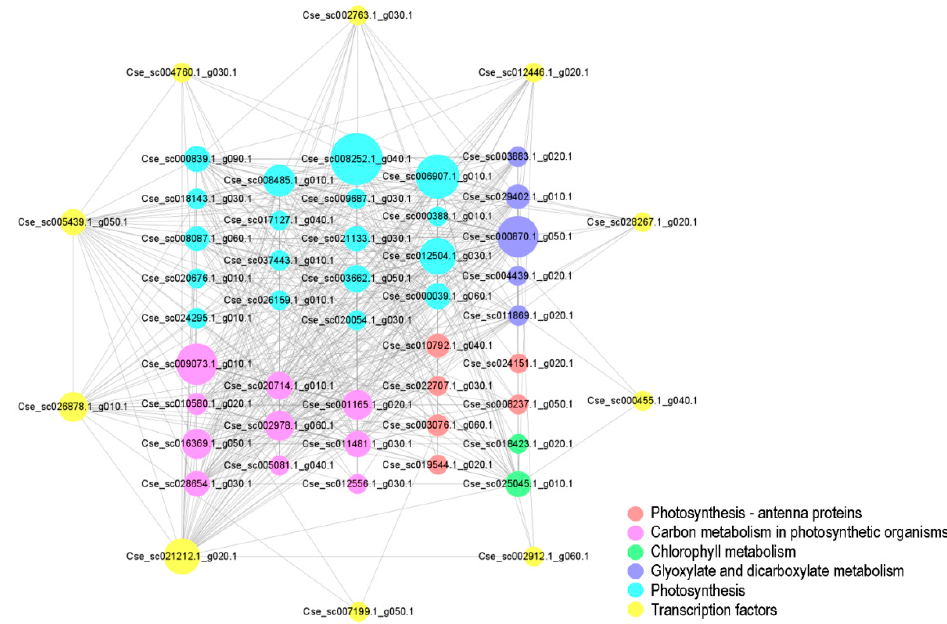
Figure 8. Network of genes in the black module. The network was constructed from 51 genes based on edge weight values. The size of the nodes represents the betweenness centrality of the node, with larger nodes having more connections with other nodes.